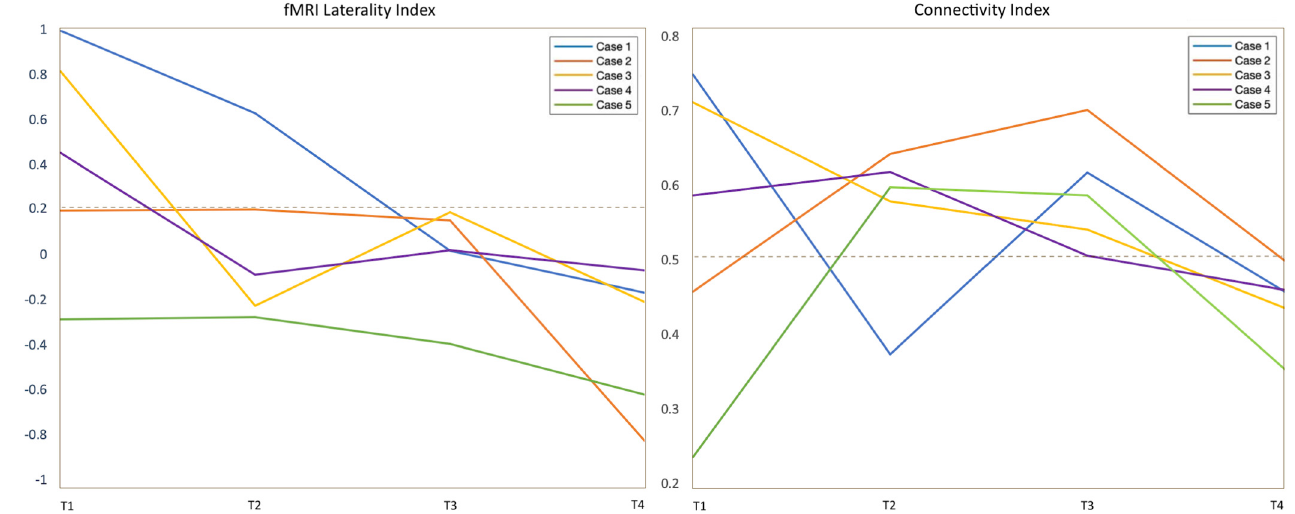
Figure 4. The left panel shows the fMRI laterality index for all cases across the four timepoints of the study (T1–T4). Values above 0.2 were considered left dominant. The right panel shows the con- nectivity laterality index for all cases across the four timepoints of the study (T1–T4). The closer the values are to 0.5, the more balanced is the connectivity between the two hemispheres. Values above 0.5 point to higher participation of the left hemisphere. LI obtained from tb-fMRI showed significant left-to-right trend in all patients across timepoints.